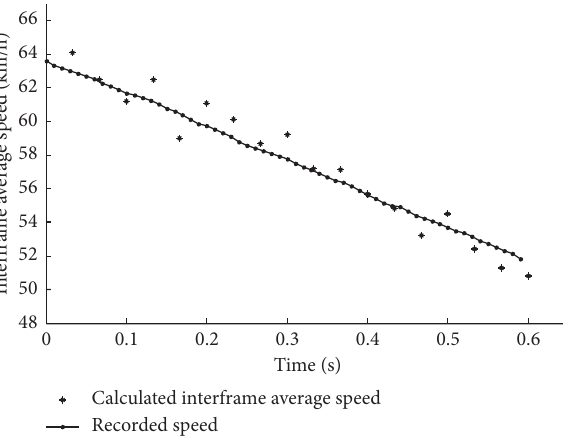
Figure 23: Compared analysis between v and v